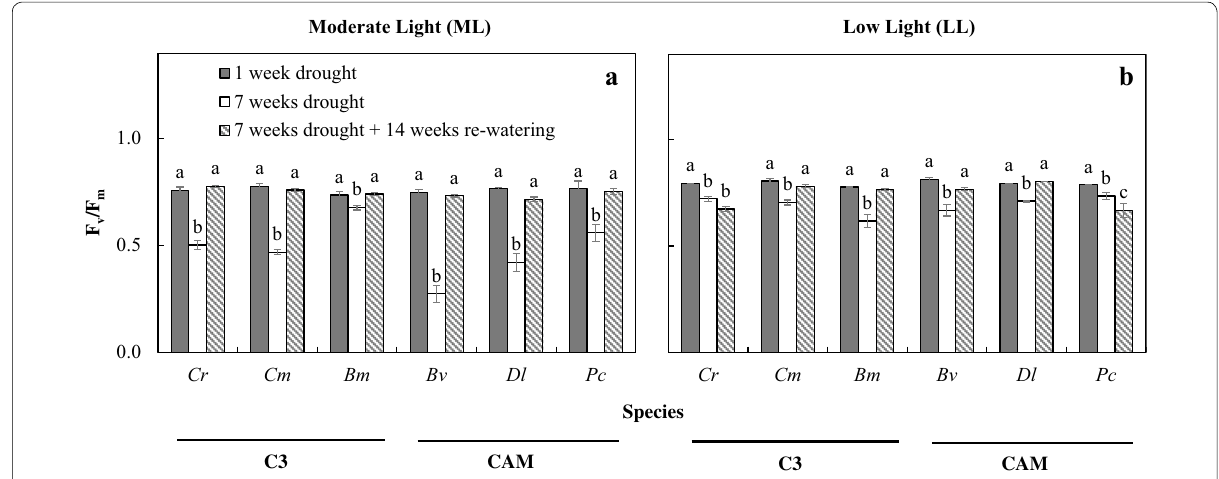
Fig. 2 Changes in F v /F m ratio in C. rochussenii ( a ), C. mayeriana ( b ), B. membranaceum ( c ), B. vaginatum ( d ), D. leonis ( e ), and P. cornu - cervi ( f ) over 21 weeks under drought and well-watered treatments at two different growth irradiances. Vertical bars represent standard error. Different letters above bars indicate statistical difference (Tukey’s multiple comparison, p < 0.05, n